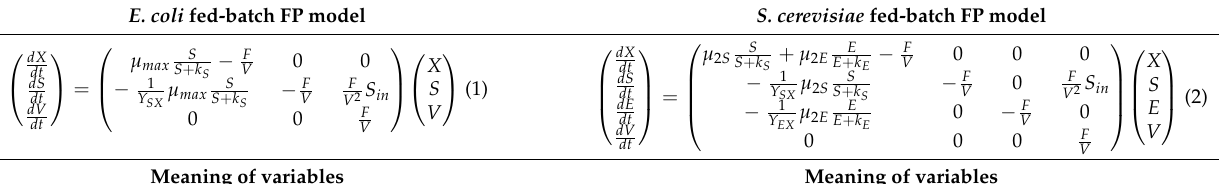
Table 1. E. coli and S. cerevisiae fed-batch FP models and vectors of identified